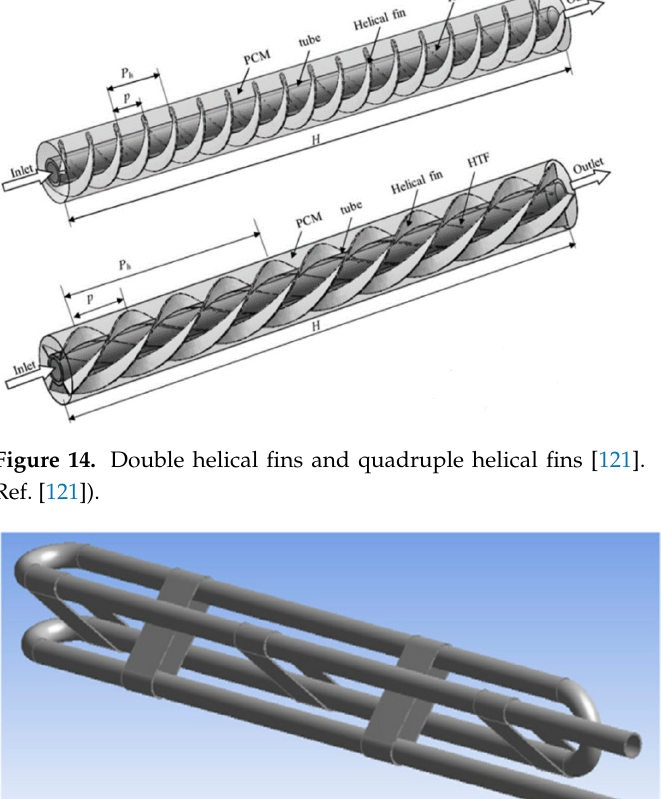
Figure 16. Wire-wound fins [125]. (Permission to reproduce from Ref. [125]).